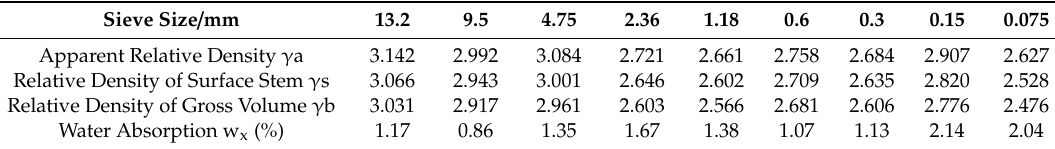
Table 3. Basic technical aggregate index.